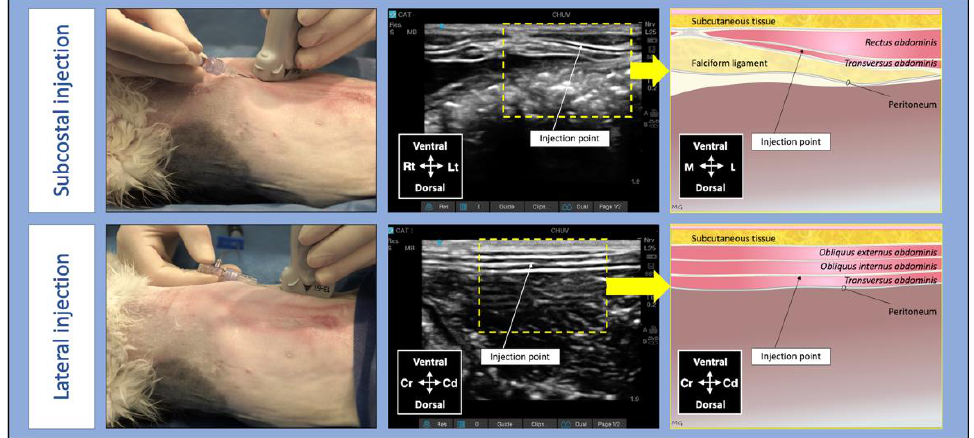
Figure 1. Techniques, ultrasound images and anatomical landmarks for the transversus abdominis plane block using lateral and subcostal injection points in a cat; Cd, caudal; Cr, cranial, L, lateral; Lt, left; M, medial; Rt, right [7] .